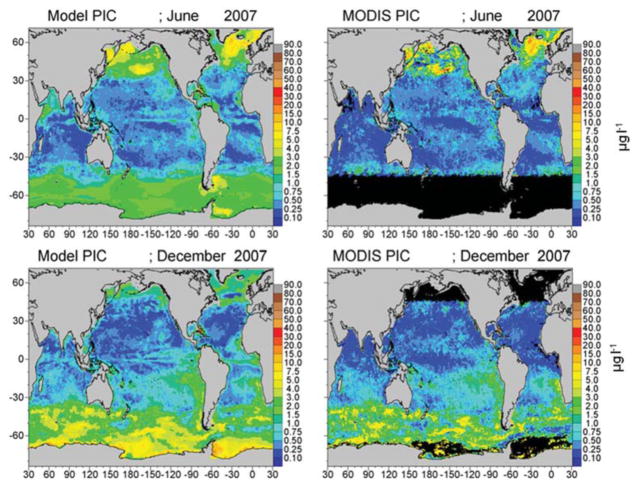
Model assimilated PIC for June and December 2007 compared to MODIS-Aqua PIC.